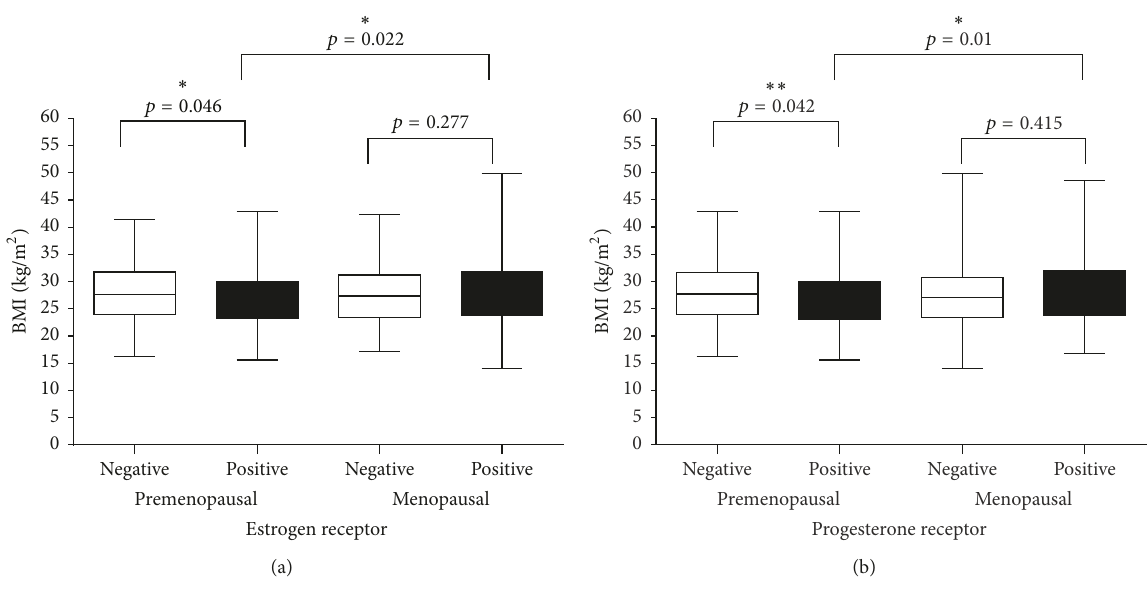
Figure 1: BMI and hormone receptor status in premenopausal and postmenopausal breast cancer patients. ∗ and ∗∗ refer to the level of significance.